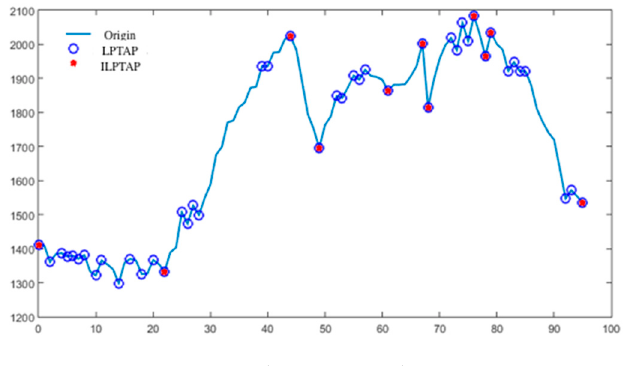
Figure 1. Daily LCTAP and ILCTAP.